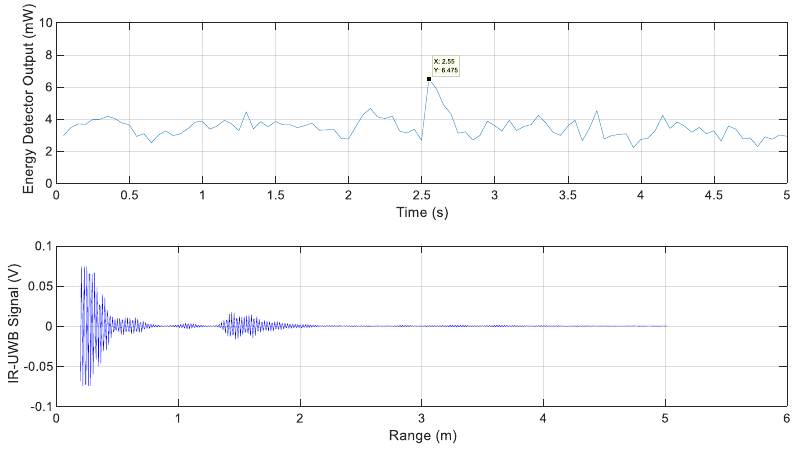
Figure 14. Energy detector output and IR-UWB signal for square manhole.